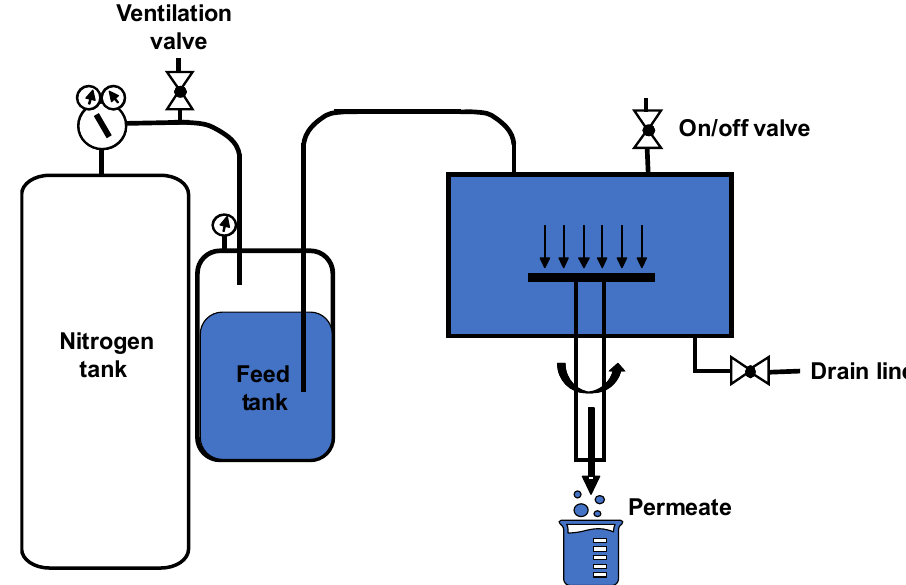
Figure 4. Schematic drawing of the filtration setup. Figure S10 in the supplementary materials provides a photograph of the experimental apparatus.